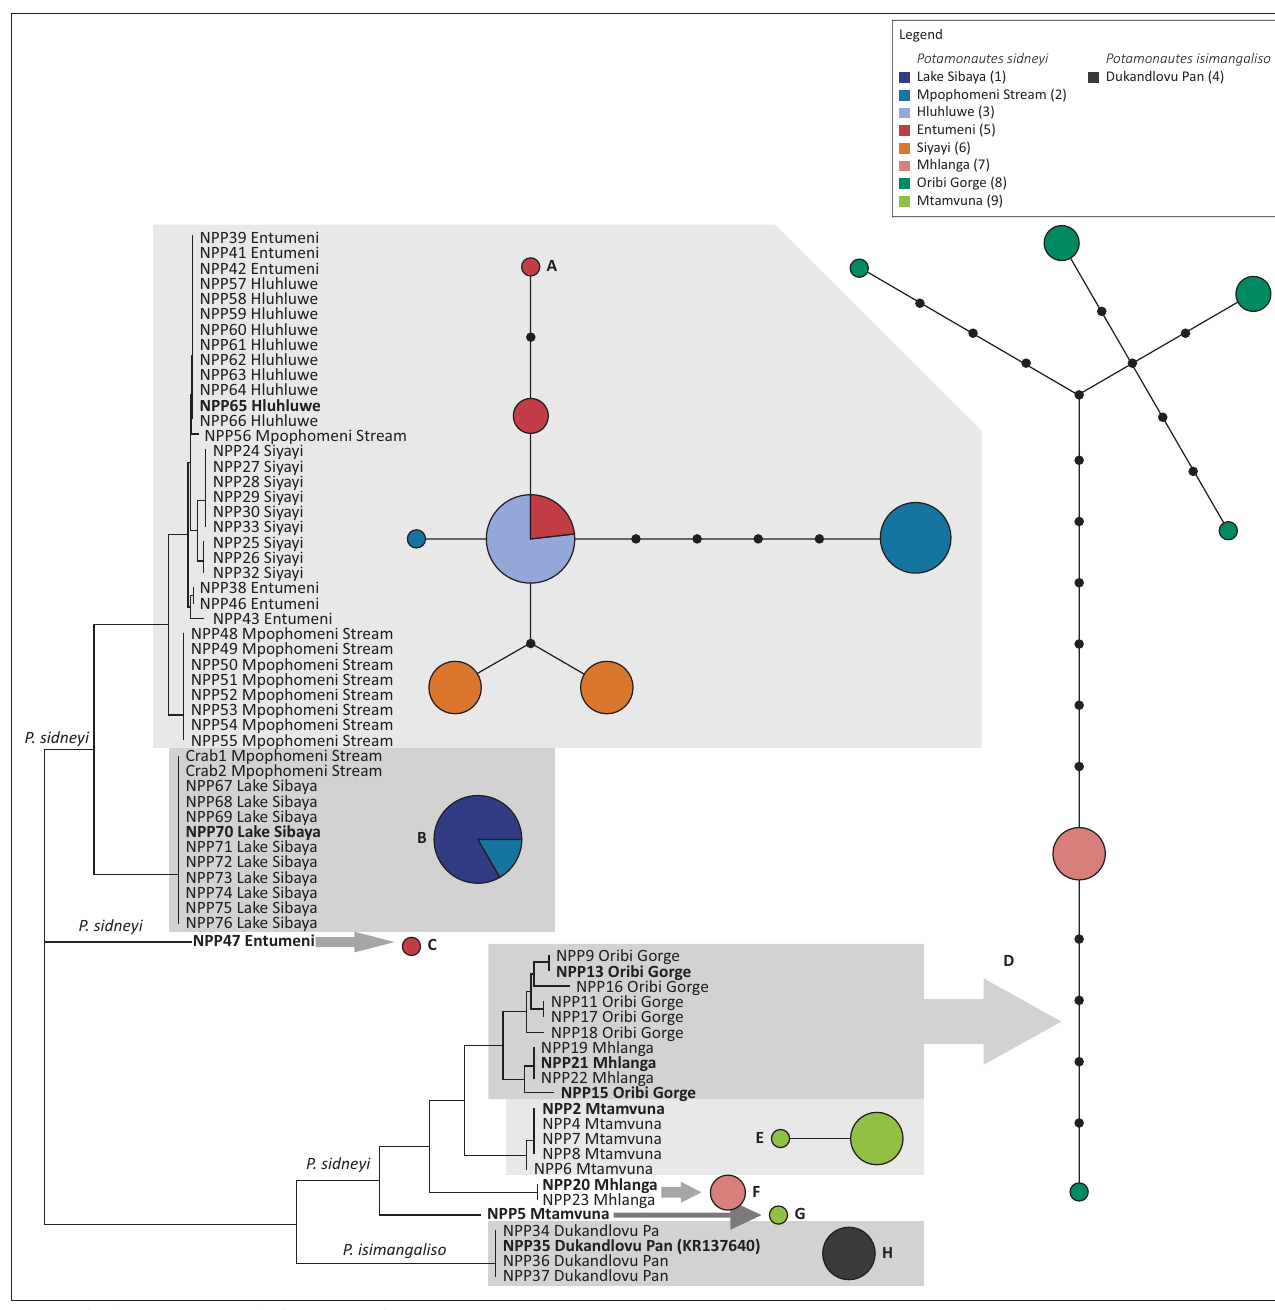
FIGURE 2: Relationships amongst cytochrome c oxidase subunit I mtDNA haplotypes found amongst Potamonautes sidneyi and Potamonautes isimangaliso individuals sampled from